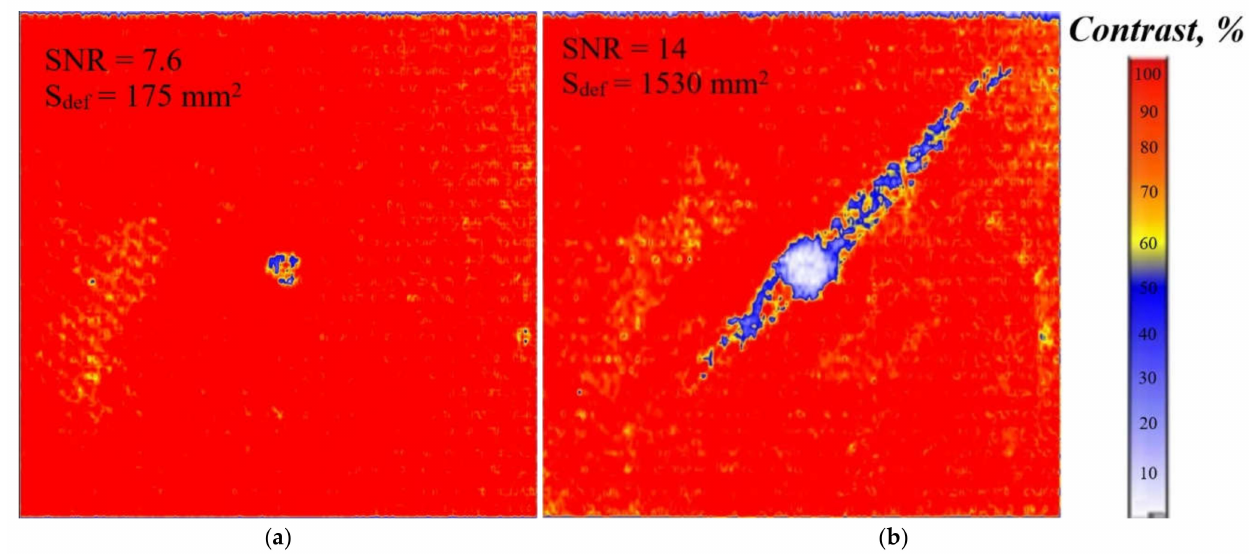
Figure 7. Ultrasonic C-scan results: ( a )-delamination depth 0.1 mm (inspecting front surface), ( b )-delamination depth 1.4 mm (inspecting rear